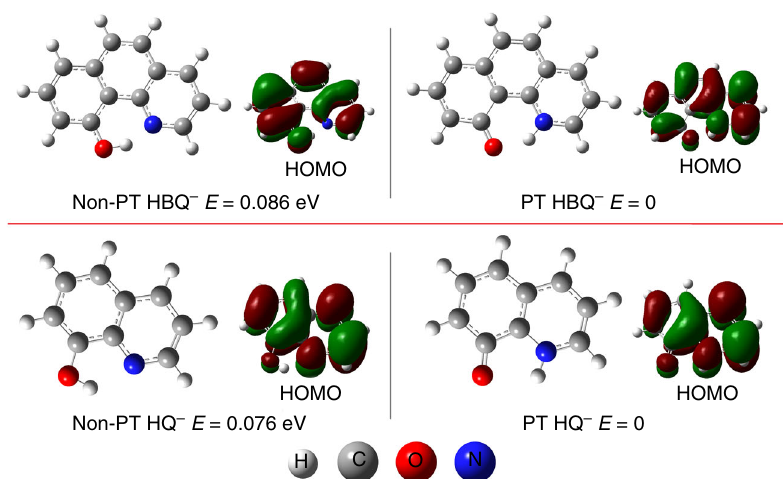
Fig. 2 Calculated structures. Calculated structures of PT and Non-PT HBQ − and HQ − , with their relative energies and HOMOs listed alongside. PT proton- transferred; Non-PT non-proton-transferred